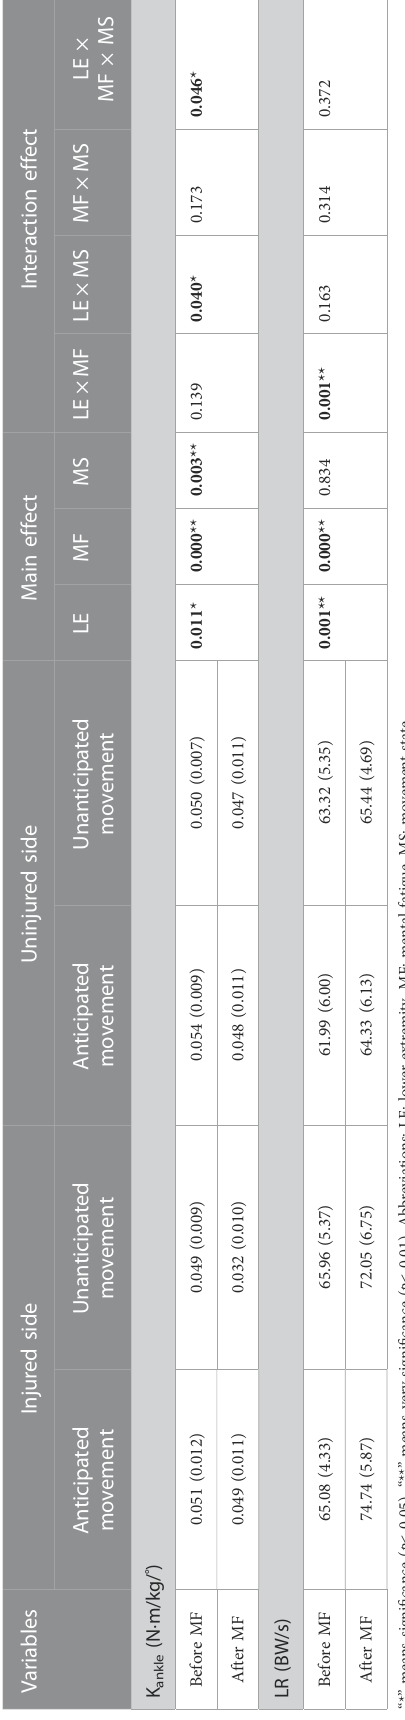
Table 3 provides the results in comparison of ankle stiffness and loading rate between the injured and the uninjured side. LE ( F =